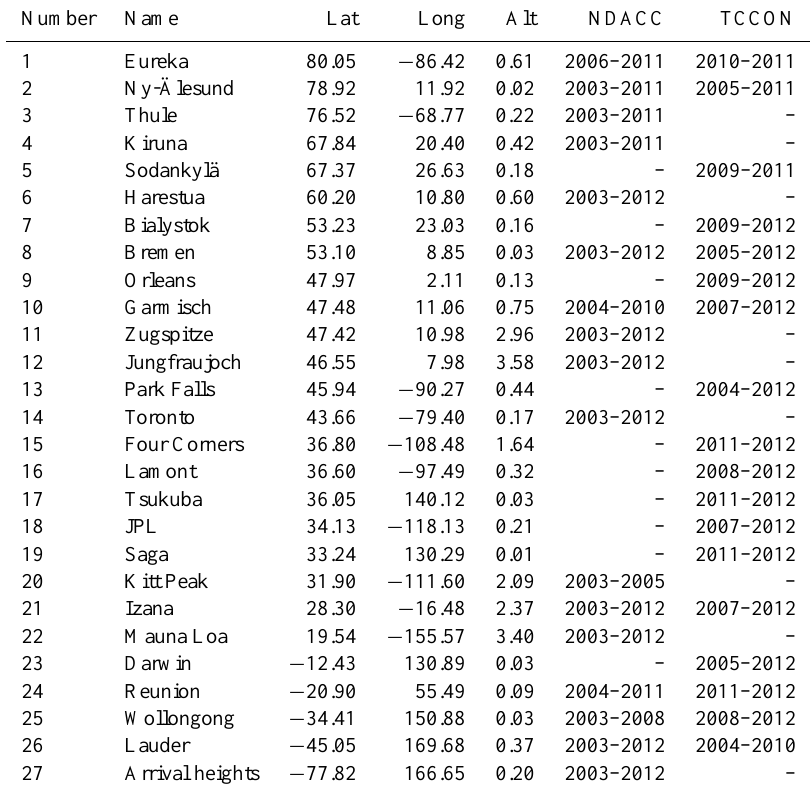
Table 2. Ground-based FTIR stations used for validation. The latitude and longitude values are given in degrees, the surface elevation in km, and the overlap in time of the stations (NDACC-IRWG/TCCON) with SCIAMACHY in